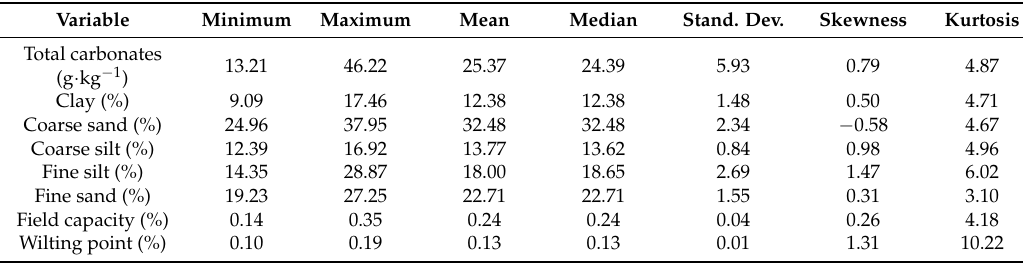
Table 3. Basic statistics of soil properties.